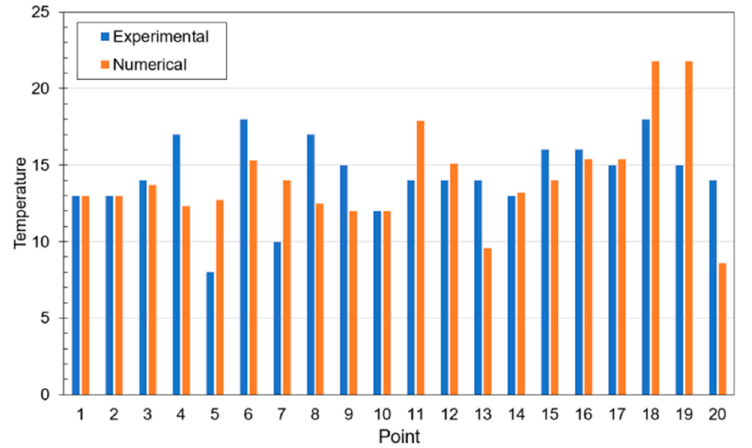
Figure 8. Experimental and numerical temperature data of large-scale assembly factory.